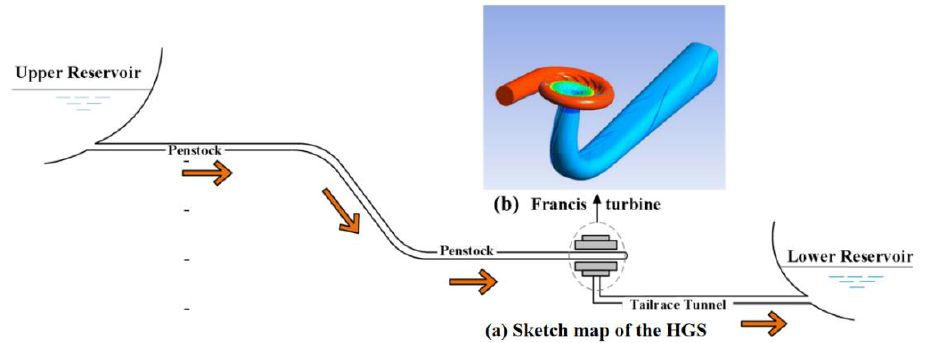
Figure 1. The sketch map of the hydropower generating system and internal characteristic Francis turbine model.